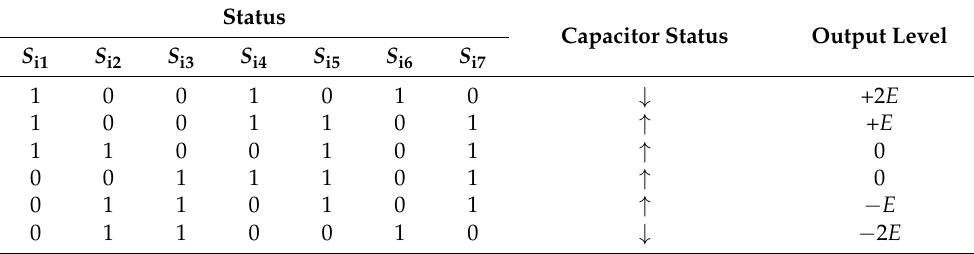
Table 2. Operating status of each